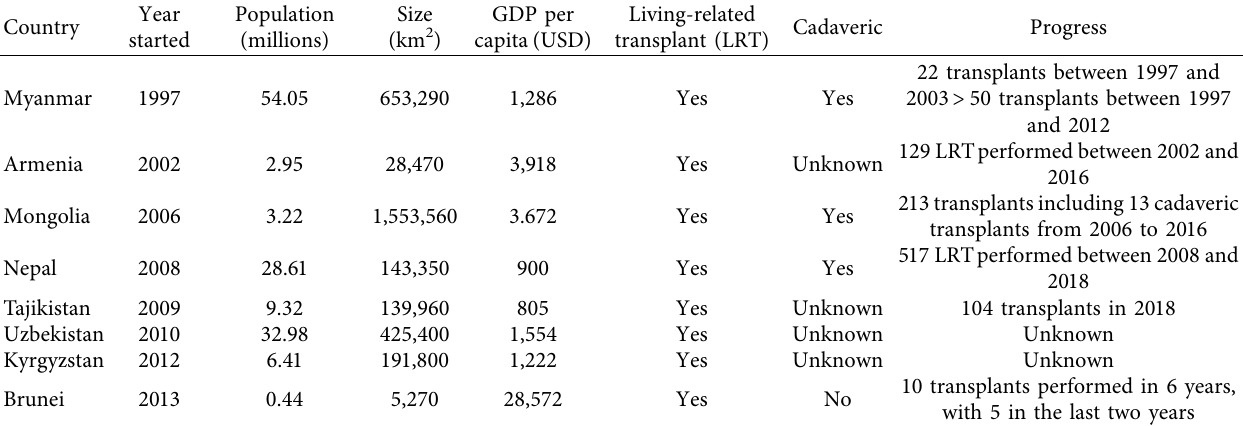
Table 1: Recent transplant programs in Asian